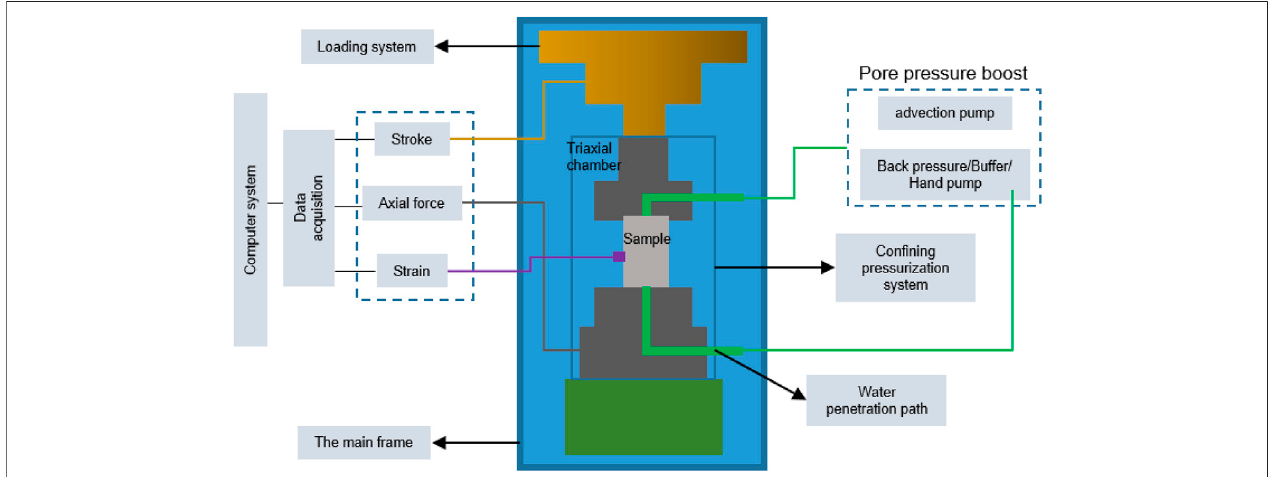
FIGURE 1 | Schematic diagram of the experimental equipment